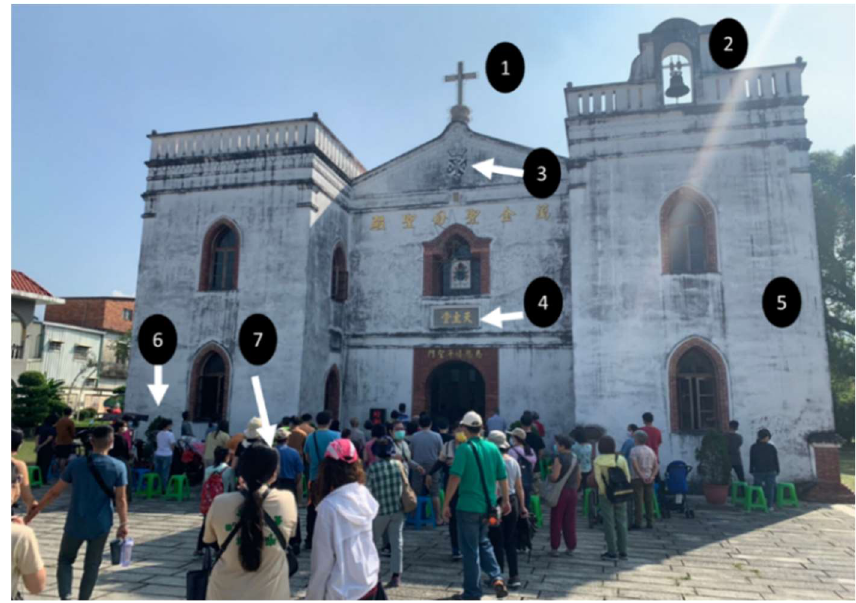
Figure 1. A photographic analysis for sustainability learning within societal transformation through individual experiences. The photo was sourced by the author:. No 1 is the crucifix transferred from Spain to Taiwan in